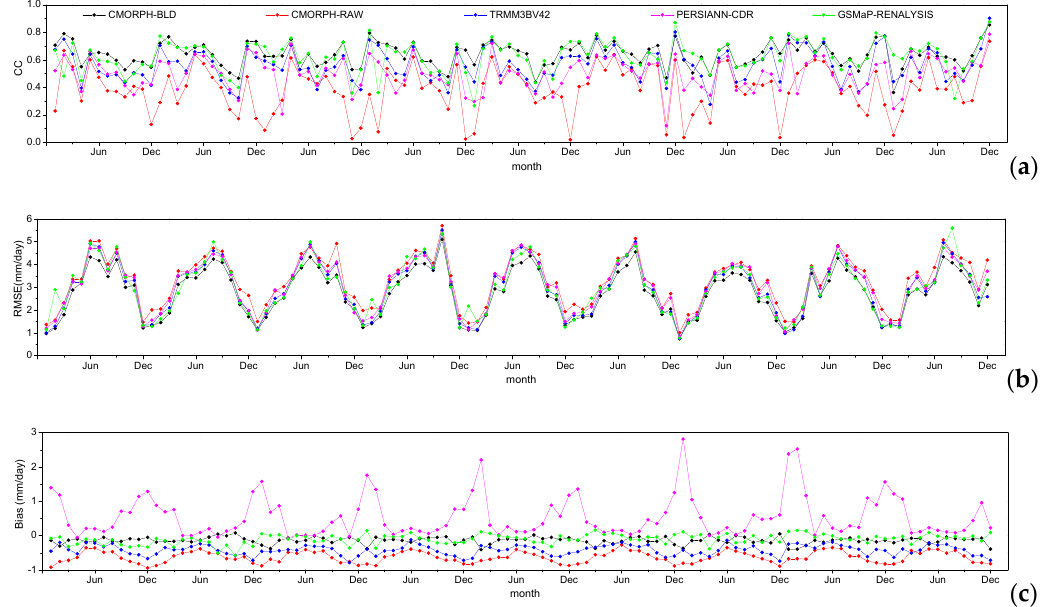
Figure 6. ( a – c ) denote the time series of the CC, RMSE and BIAS from a variety products spanning 2005 to 2013 over China, respectively.